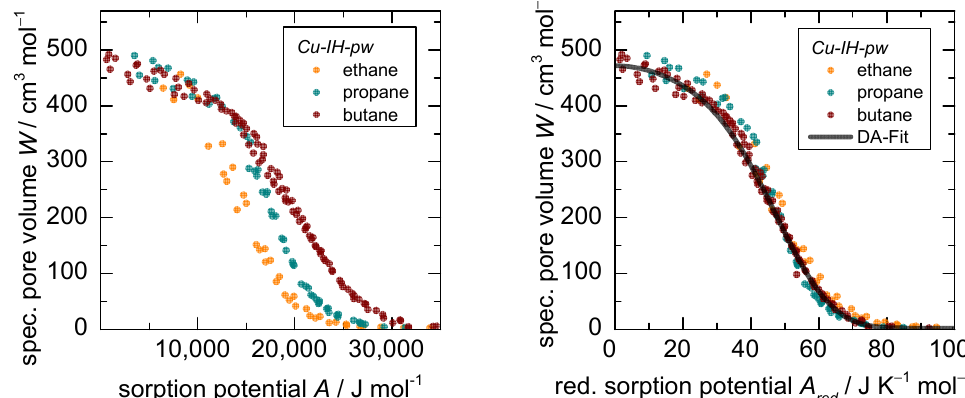
Figure 4. Dubinin plot before ( left ) and after ( right ) application of the Dubinin-based universal ad- sorption theory ( D-UAT ) ethane, propane, n -butane on the rigid Cu-IH-pw at 283 K, 298 K, and 313